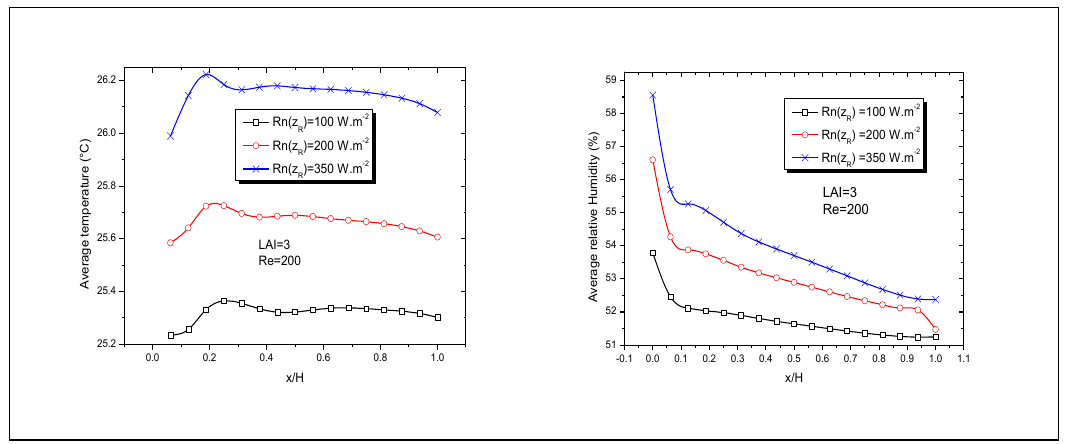
Figure 8 . Variation in average temperature and relative